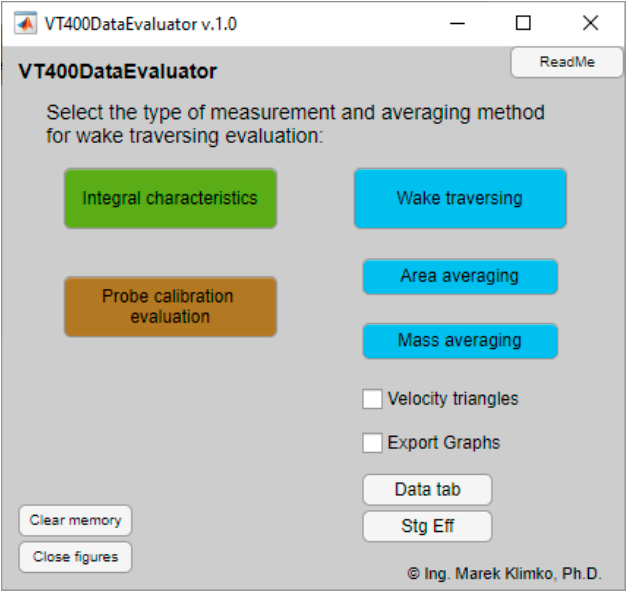
(cid:0) (cid:1) (cid:0) (cid:1) C ϕ , C θ C ϕ , C θ ; θ ; C stat ( ϕ , θ ) ; C tot ( ϕ , θ ) [11].